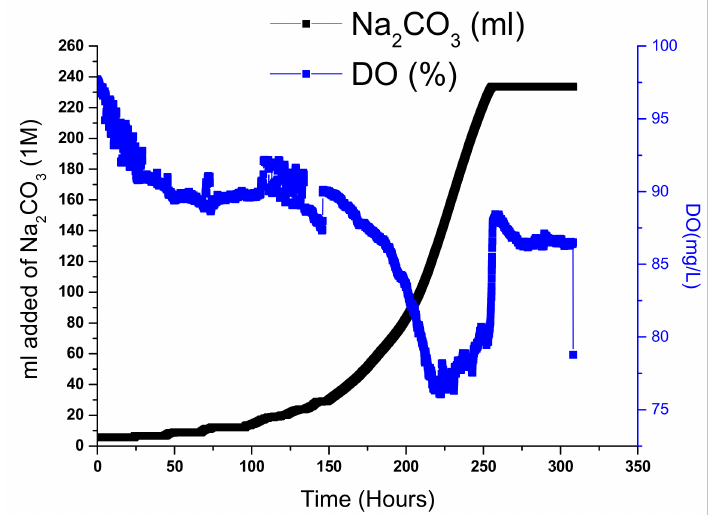
Figure 5. Relationship between DO consumption and pumped Na 2 CO 3 − 2 1